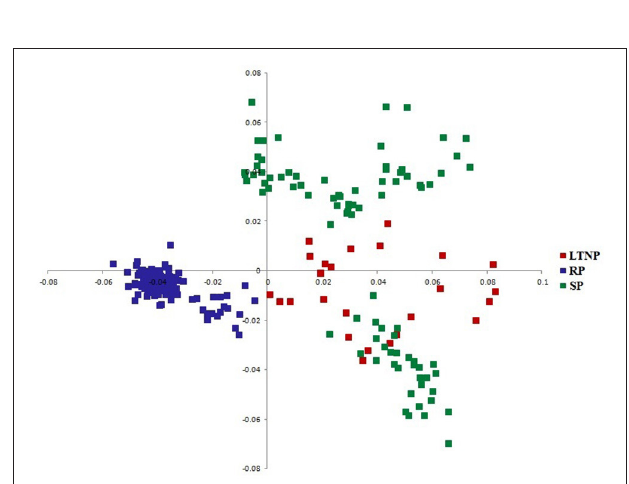
FIGURE 2 | Distribution of env genes along the two major axes of correspondence analysis (COA) based on RAAU data. x-axis- Axis 1 of RAAU; y-axis- Axis 2 of RAAU. Red colored square boxes represent Long term non-progressor (LTNP) sequences. Blue colored square boxes depict Rapid progressor (RP) sequences. Green colored square boxes refer to Slow progressor (SP)